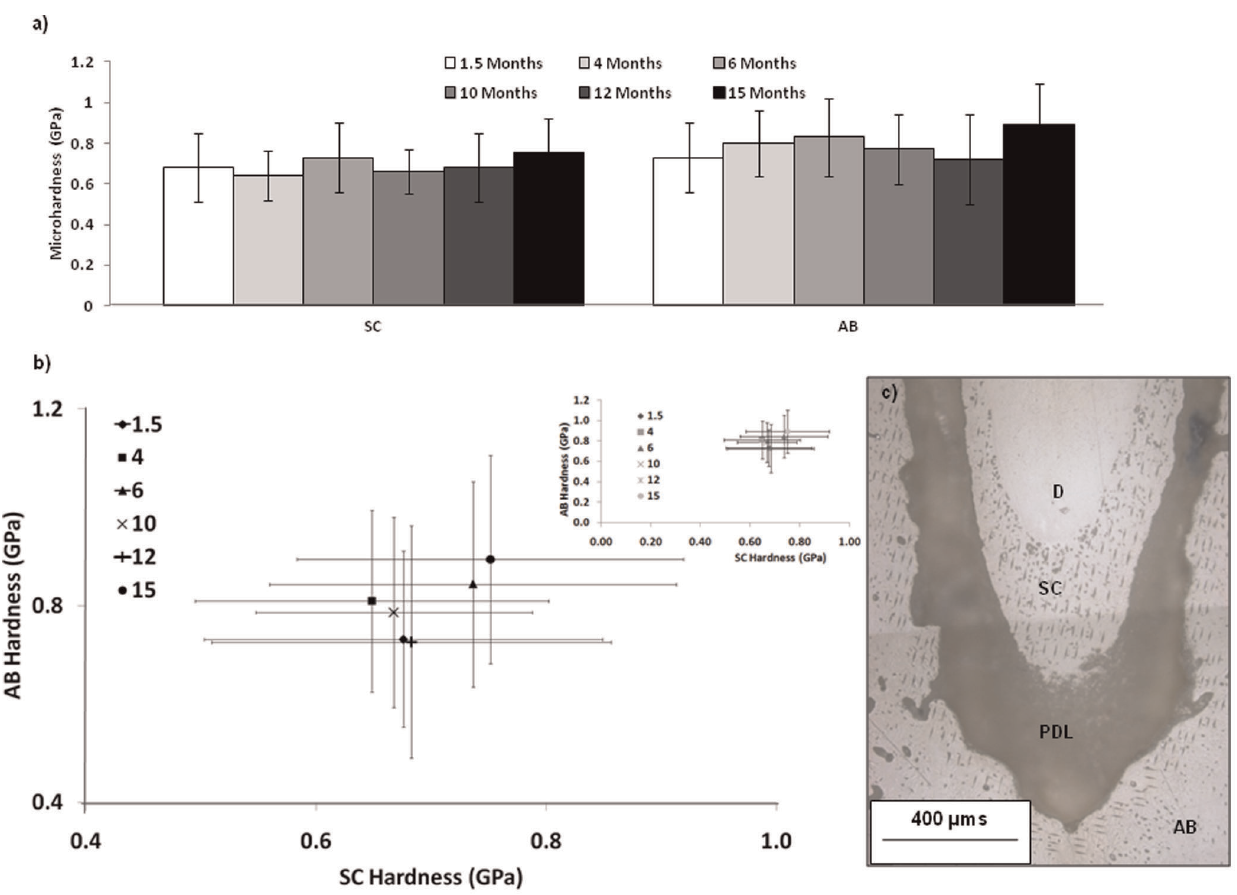
Figure 7. Hardness values for secondary cementum (SC) and alveolar bone (B) with age. a) Histogram shows average calculated Knoop hardness and standard deviation (GPa) values for SC and B. Values demonstrated no significant differences in both SC and B microhardness with age. b) Inset demonstrates original values plotted with reference to the origin. The main plot zooms into the clustered data set to demonstrate that the discrete points showed no relationship between SC and B with progression of age. c) Typical microindentation distribution and pattern conducted under dry conditions is shown at 10X.